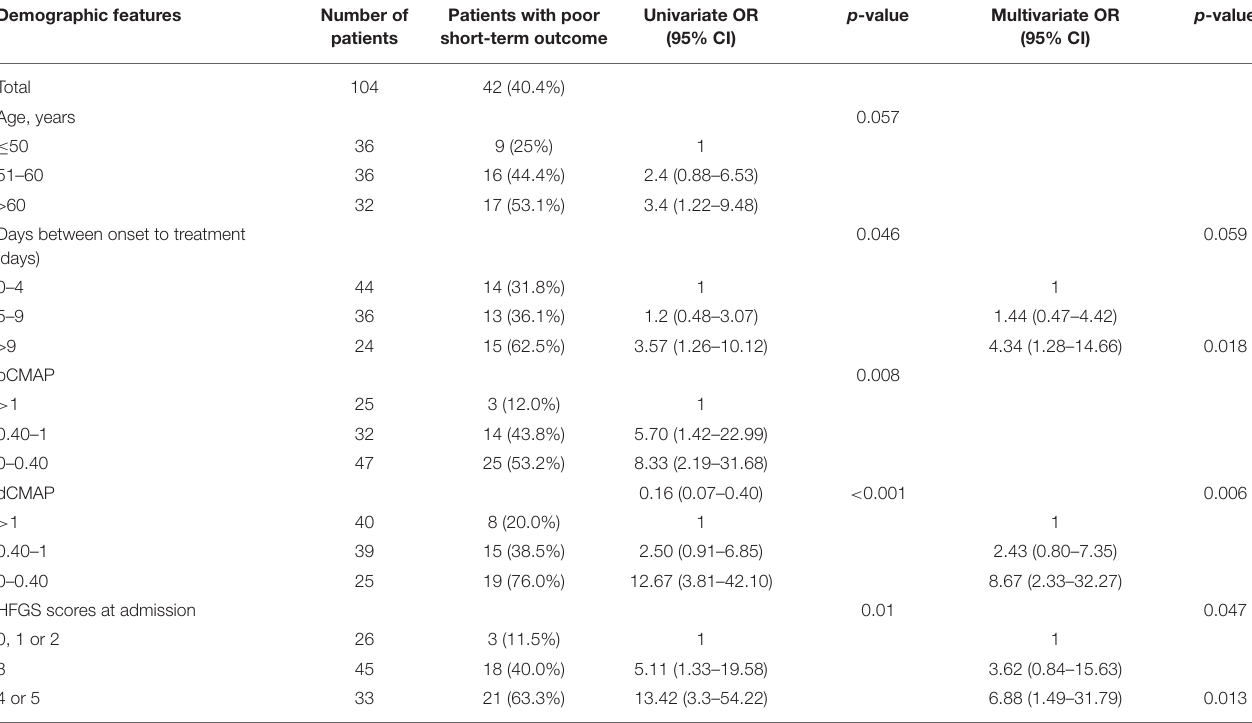
TABLE 2 | Univariate and multivariate regression analyses of the risk of poor short-term prognosis of GBS patients. Demographic